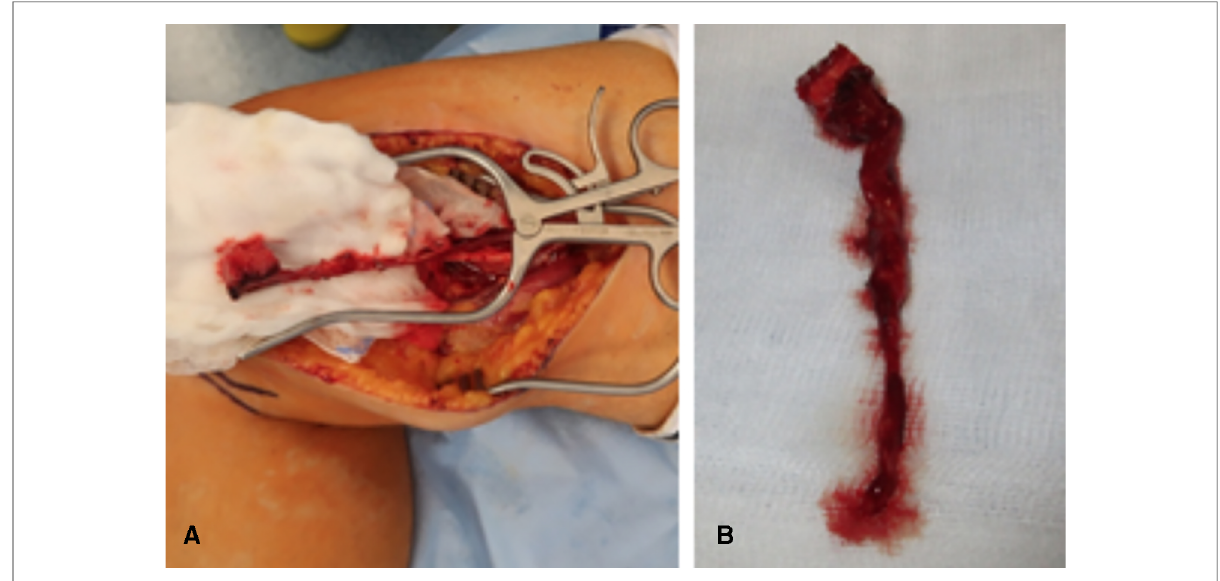
FIGURE 1 ( A ) Intraoperative view showing the harvesting of a medial femoral condyle. ( B ) Intraoperative view showing the harvested bone graft with a long